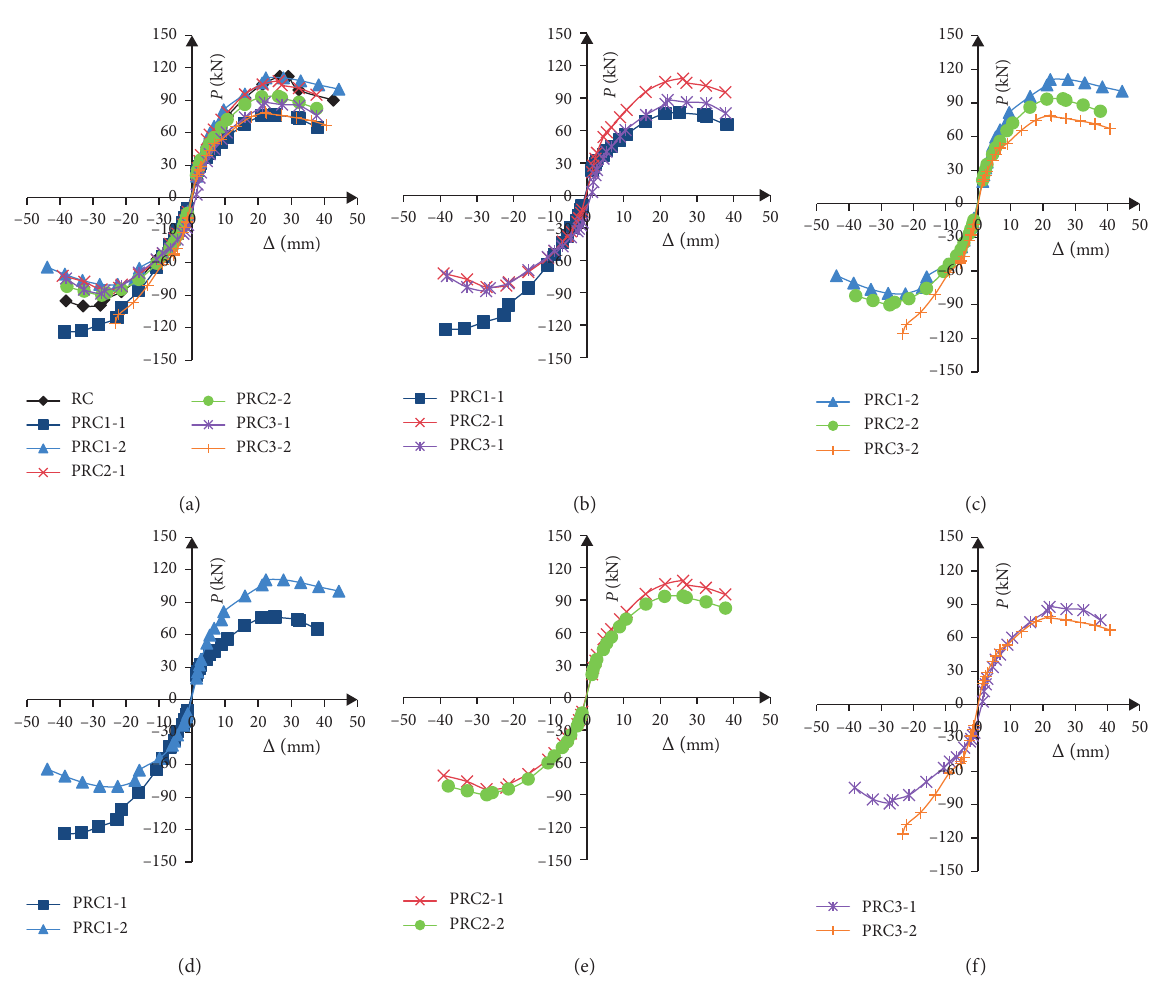
Figure 9: Comparison of skeleton curves of different specimens. Table 3: Load-carrying capacity and deformation capacity of